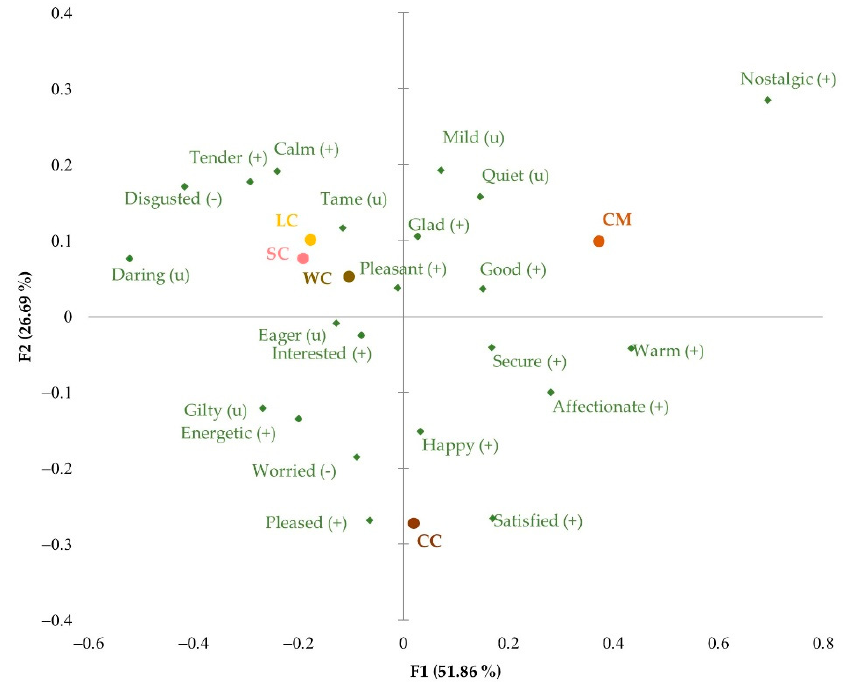
Figure 8. Principal component analysis of the significant emotional responses corresponding to class 2: WC, Walnut cake; LC, Leonor cake; SC, Saffron cake; CC, Coulant cake; CM, Chocomuffin.